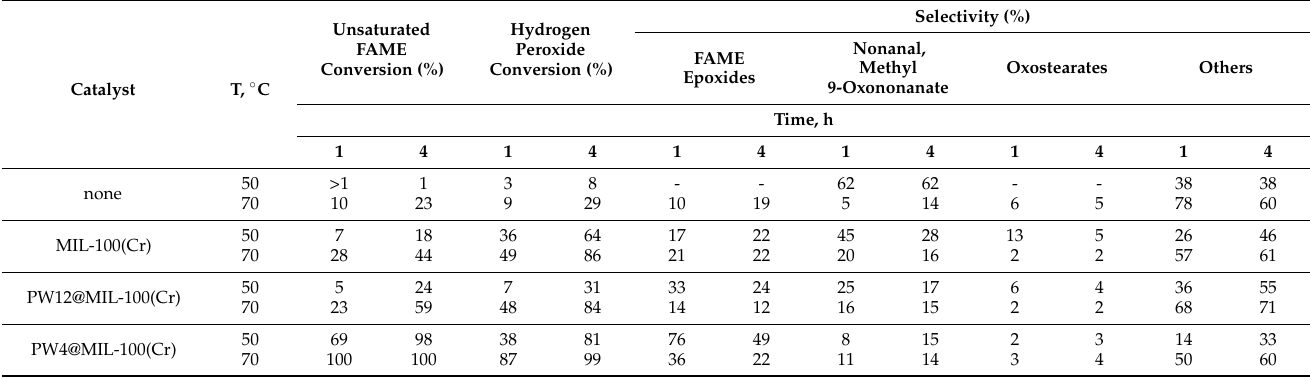
Table 3. Catalytic tests of MIL-100(Cr), PW12@MIL-100(Cr) and PW4@MIL-100(Cr) a